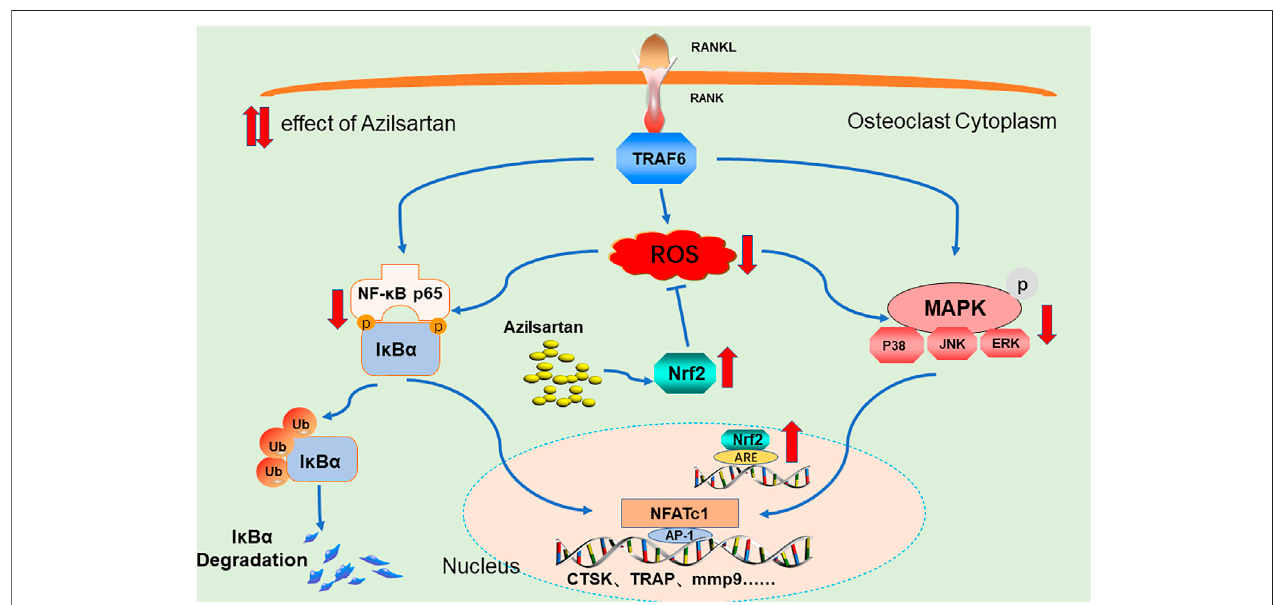
FIGURE 8 | A Proposed scheme of Azilsartan inhibits osteoclastogenesis by suppressing ROS production. Mechanistically, Azilsartan inhibits RANKL-induced activation of NF- κ B and MAPK pathways by activating Nrf2 signaling.